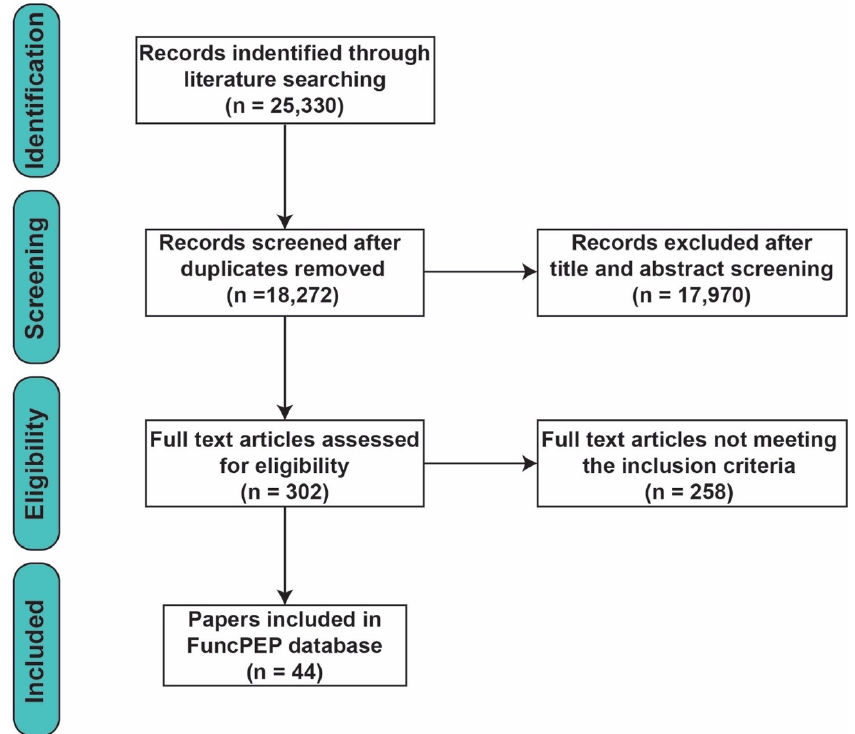
Figure 1. Flowchart describing the process of scientific paper identification, screening, eligibility testing, and inclusion.